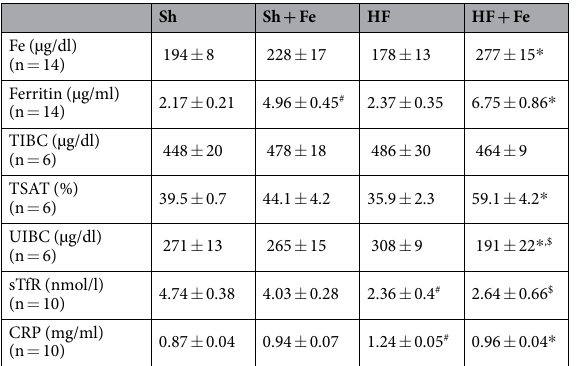
Table 3. The effect of iron supplementation on the serum parameters of iron turnover in failing (HF) and control rats (Sh). Fe, iron concentration; TIBC, total iron binding capacity, TSAT, transferrin